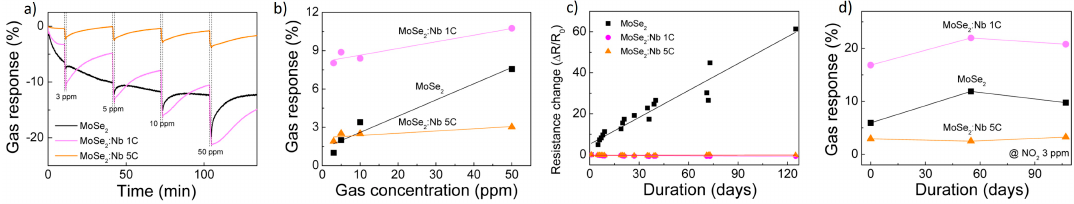
Figure 13. ( a ) Dynamic response of the Nb-doped MoSe 2 devices at NO 2 concentrations ranging from 3 to 50 ppm; and ( b ) responses of the three devices as a function of the NO 2 gas concentration. ( c ) Resistance change data over 120 days: Nb-doped MoSe 2 devices showed negligible resistance change, differently from MoSe 2 devices. ( d ) Comparison of the long-term stability of the three devices with respect to the gas sensing response. All gas-sensing tests were performed at an operating temperature of 150 °C. Reprinted with permission from [92]. Copyright (2017) American Chemical Society.